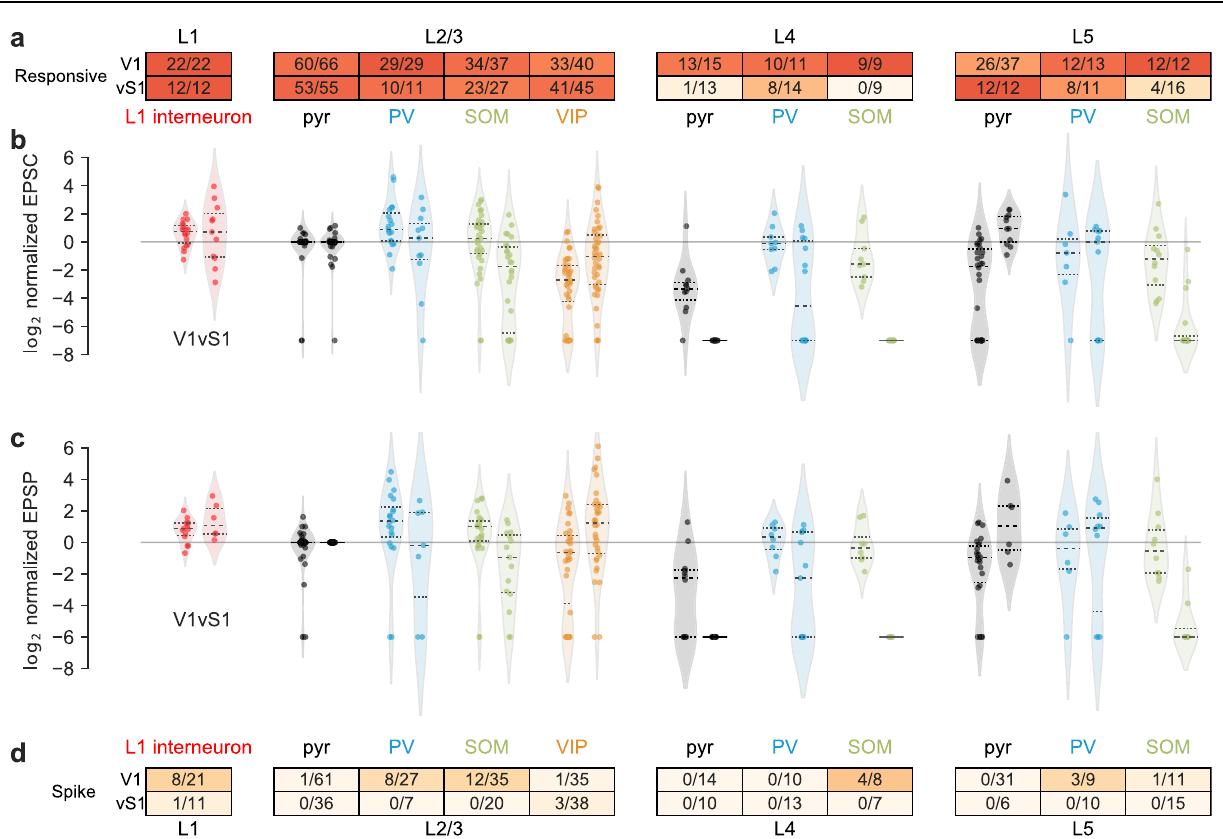
panels ( a ) and ( d ). Each dot indicatesone recorded cell and the color indicatesthe cell type. The black dashed lines indicate the quartiles (top and bottom) and the median (middle). The outlines indicate the distributions of the log2 normalized EPSCs. c Sameas( b ),forlog2normalizedEPSP. d Theproportionofspikingcellsin V1 or vS1 in different layers (number of spiking cells/total cells recorded in the current-clamp mode). Source data are provided as a Source Data fi